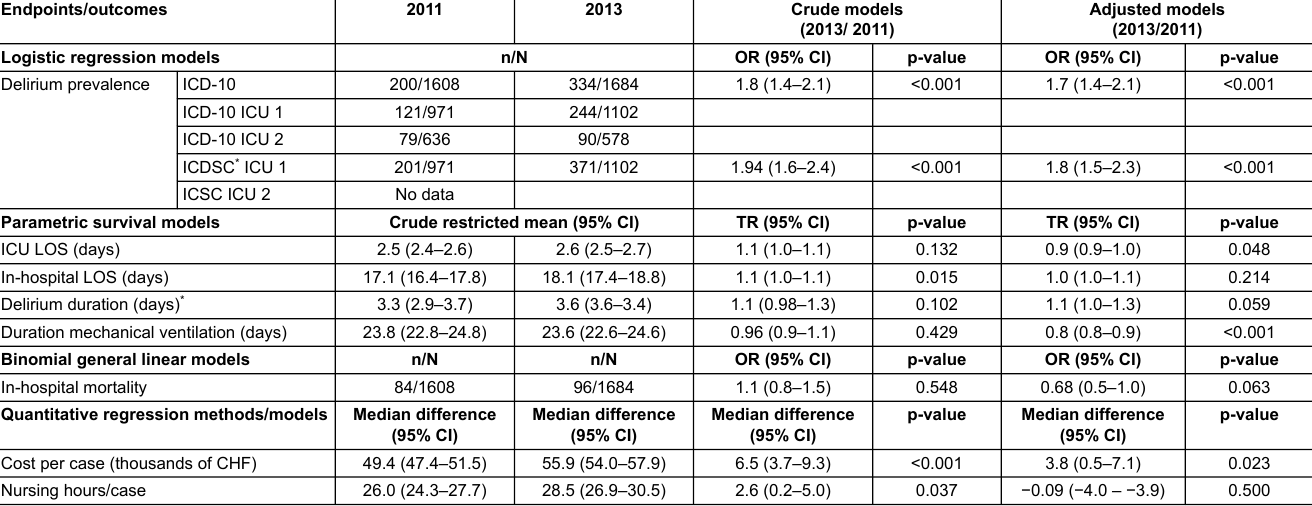
Table 3: Effectiveness, costs and benefits of the delirium management